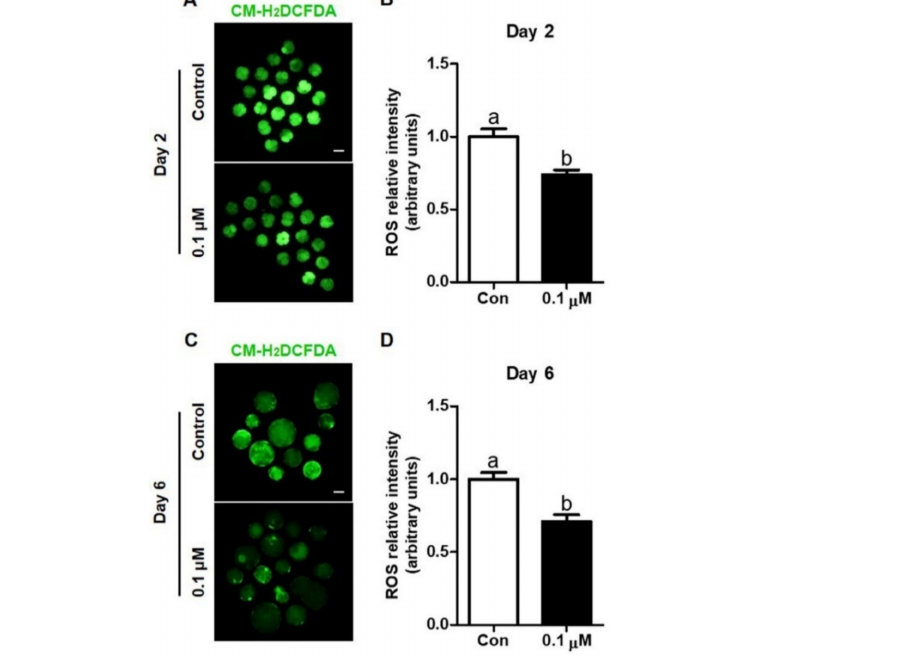
Figure 3. Effect of lycopene on the intracellular ROS levels in porcine IVF embryos. ( A , C ) Represen- tative images of CM-H 2 DCFDA staining of Day-2 embryos and Day-6 blastocysts treated with or without 0.1 µ M lycopene. ( B , D ) Intracellular ROS levels in Day-2 embryos and Day-6 blastocysts in the indicated groups. Different superscript letters (a,b) represent the significant difference ( p < 0.05). Bar = 100 µ M. Abbreviations: ROS, reactive oxygen species; IVF, in vitro fertilized; CM-H 2 DCFDA, 5- [and-6]-chloromethyl-20, 70-dichlorodihydro-fluorescein diacetate, acetyl ester; Con, control; 0.1 µ M, 0.1 µ M lycopene.